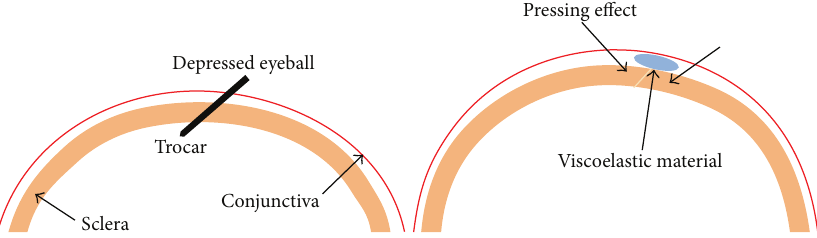
Figure 1: Schematic showing the mechanism of subconjunctival viscoelastic material injection. Flattening of the globe and conjunctival slippage occurred, and there was slight displacement of entry site between the conjunctiva and sclera. Subconjunctival injection of viscoelastic material had a transient tamponade effect on the sclerotomy site following pressing of the sclera beneath the conjunctiva.